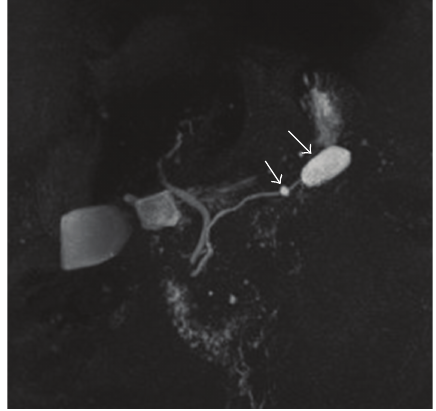
Figure 4: BD-IPMN with 2 cysts (arrows) communicating with nondilated main pancreatic duct on MRCP.